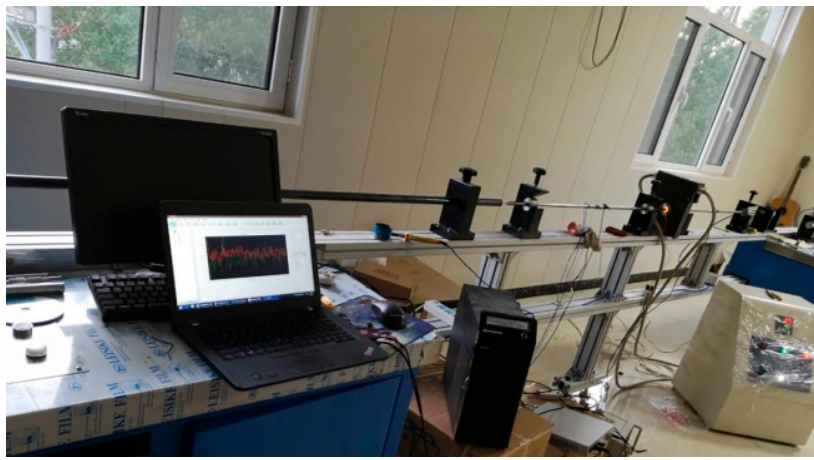
Figure 2. Device diagram of split Hopkinson pressure bar experiment.